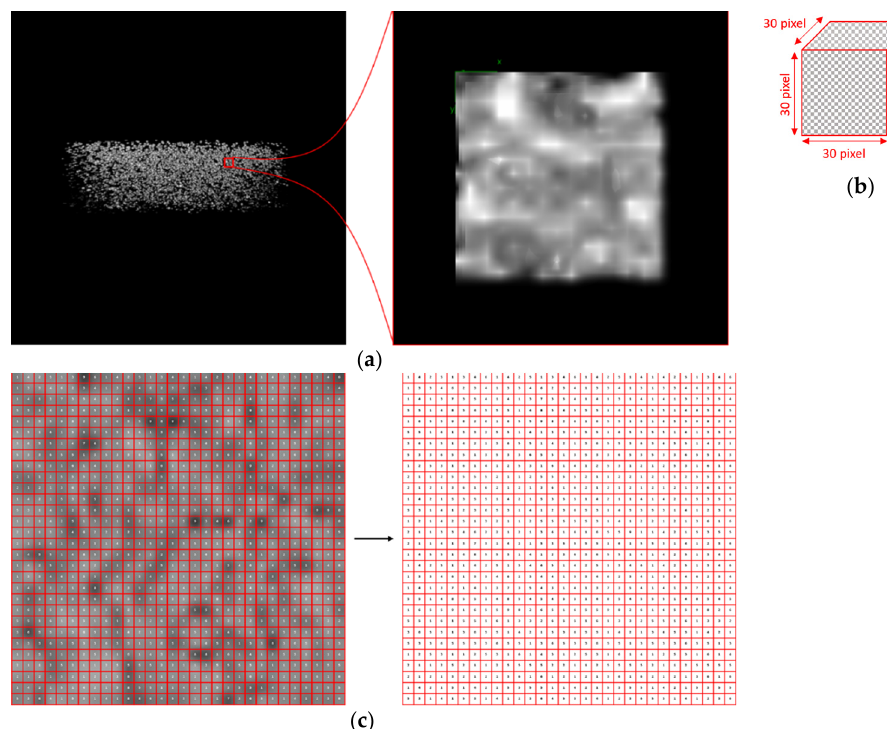
Figure 3. Image processing and data preparation for the classifier: ( a )—OCT scan of phantom and the VOI cube image; ( b )—schematic view of the 3D cube of the size 30 × 30 × 30 pixels; ( c )—extraction of grey level of each pixel for further grey-level co-occurrence matrix analysis.